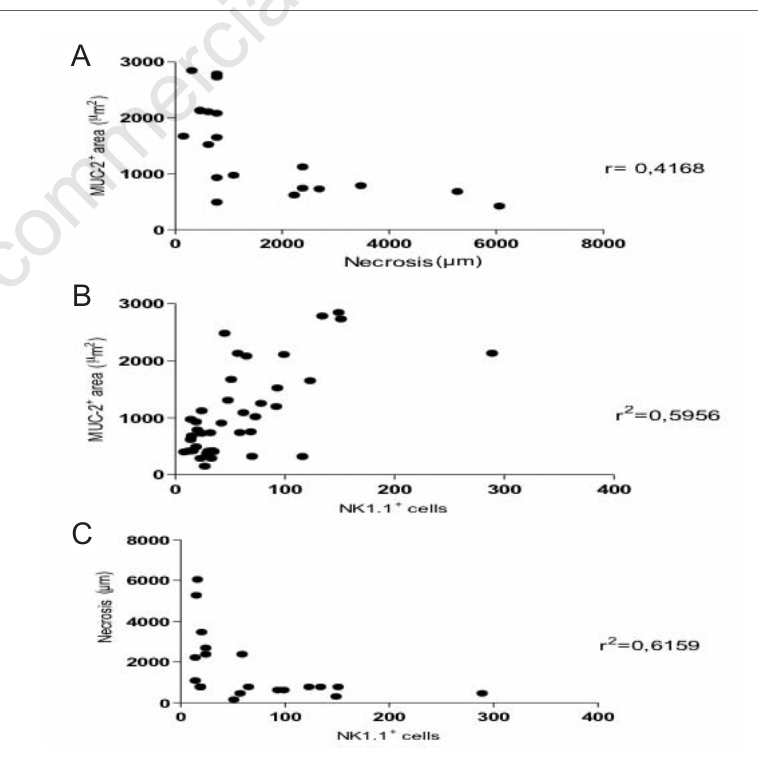
Figure 6. Immunohistochemical reaction for MUC-2 mucin in the caeca of C57BL/6 wild type and C57BL/6CD1 -/- mice inoculated or not with Entamoeba histolytica . A) non- infected-wild type group: note the presence of MUC-2 staining (arrowheads) in the mucosa as seen by brown staining; B) Entamoeba-wild type group: increase of the MUC- 2 + area (arrowheads) in the mucosa compared to the previous figure; C) non-infected- CD1 -/- group: smalls areas of MUC-2 staining (arrowheads); D) Entamoeba-CD1 -/- group: increase of the MUC-2 staining (arrowheads) in the mucosa in relation to Figure 6C; inflammatory infiltrate (*). Counter-staining with Harris haematoxylin. Bar = 20 µm. M, Mucosa M; S, Submucosa, Mu, Muscular; Se, Serosa.